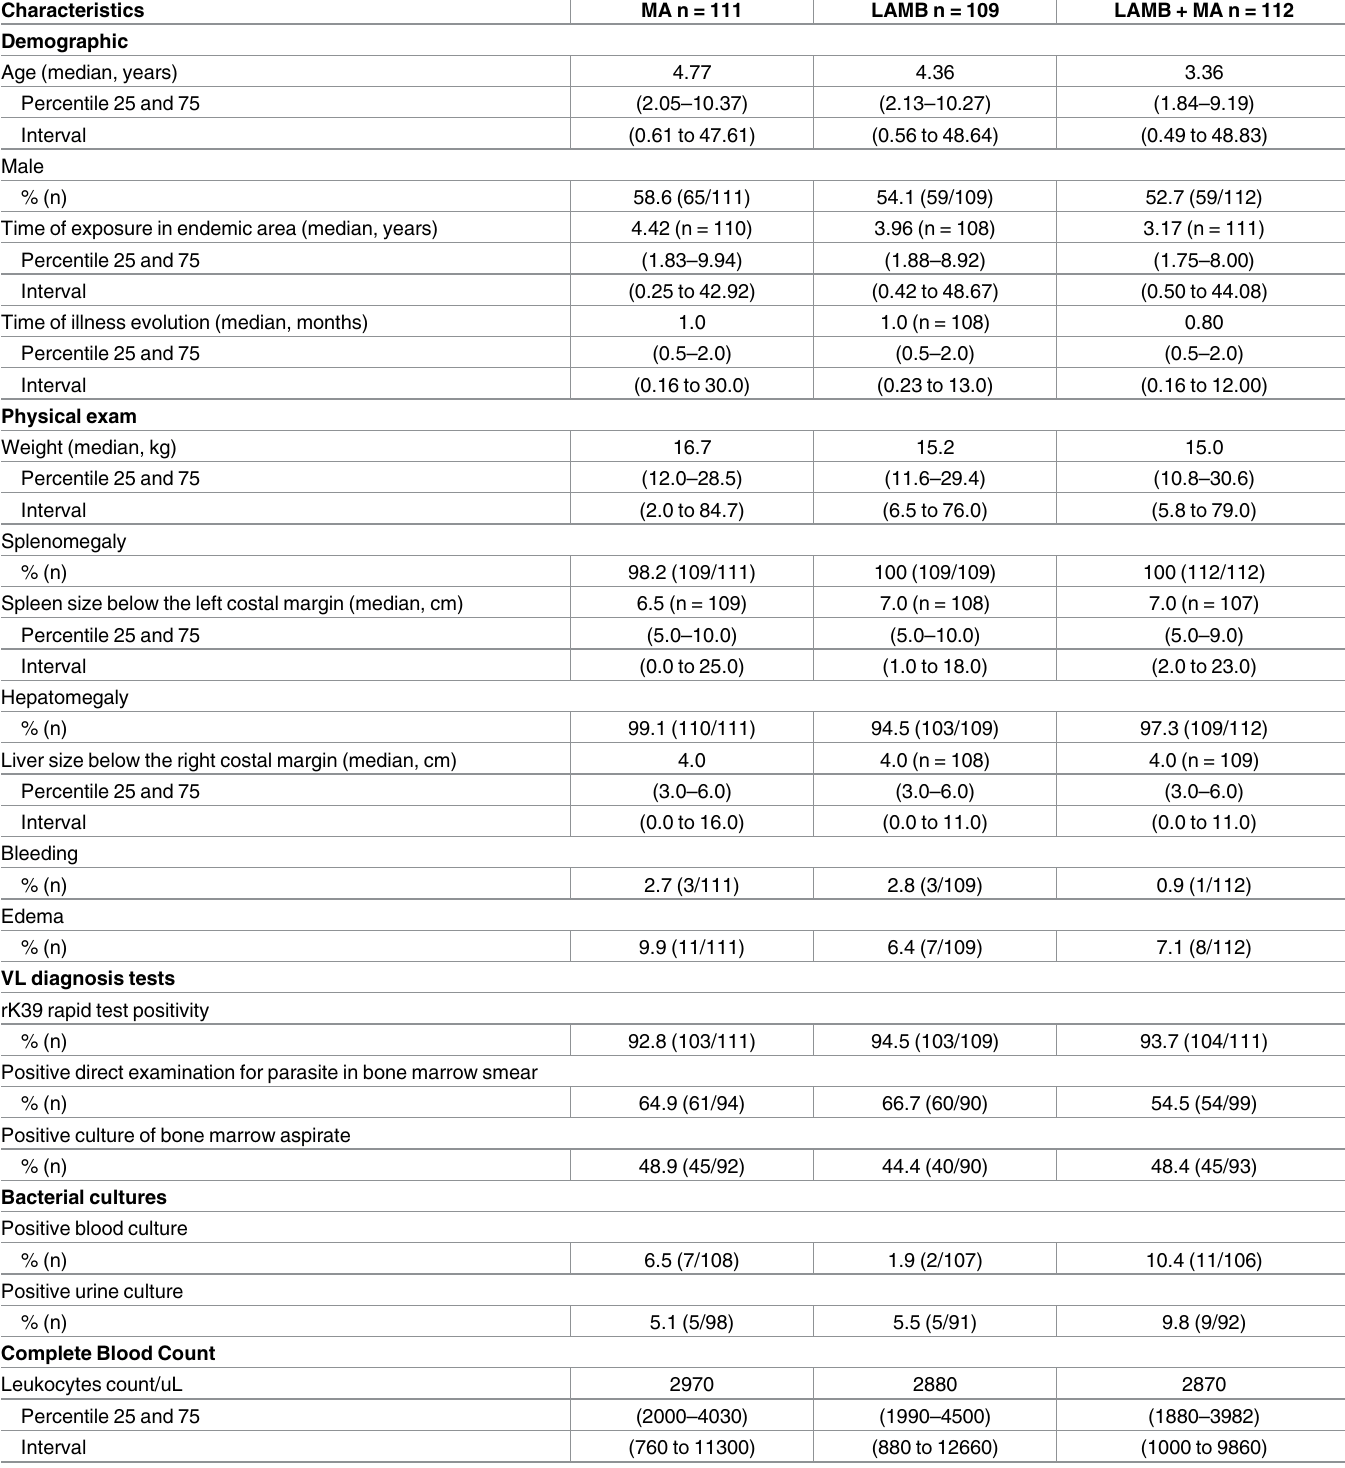
Table 1. Baseline demographic, clinical and laboratory characteristics of 332 participants effectivelyrandomized to the three remaining arms of the trial.